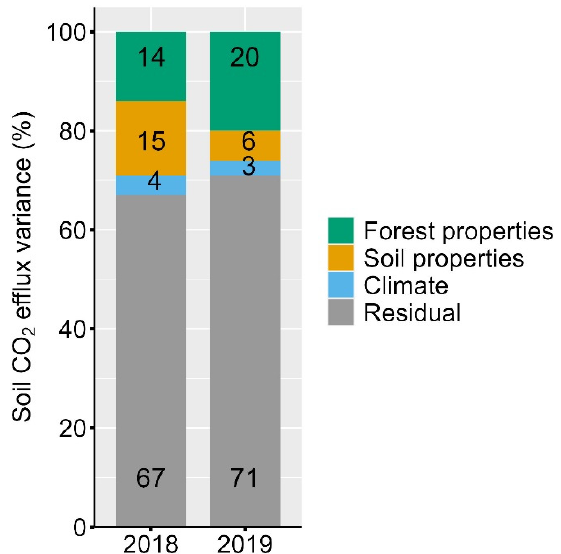
Figure 4. Soil CO 2 efflux variance partitioning among forest properties (stand age, basal area, mean breast height diameter, tree density, conifer share, tree species diversity and fine root biomass), soil properties (organic layer and mineral soil OC stock, soil C:N ratio, silt content and pH) and soil climate (soil temperature and volumetric water content) for the two sampling campaigns in 2018 and in 2019.